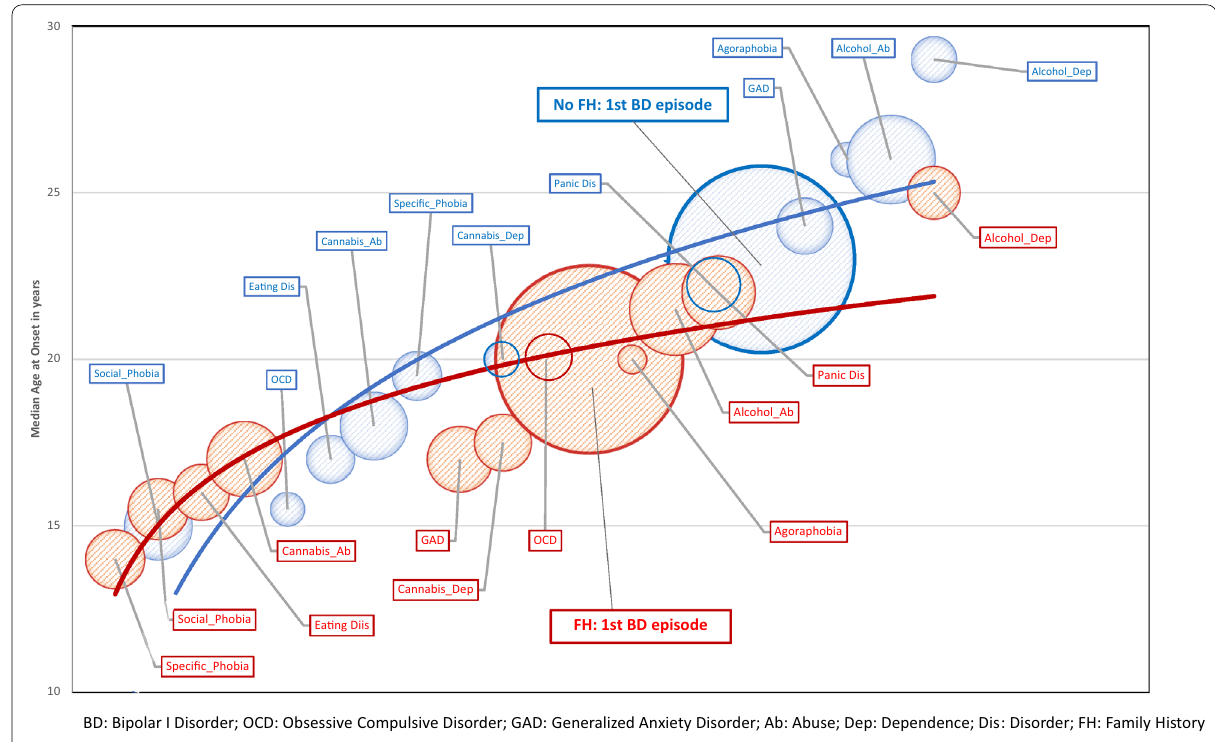
Fig. 1 Trajectories of evolution of BD-I in groups with (FH) or without (no FH) a family history of Bipolar I Disorder (BD). In the bubble plot, the size of the bubble represents the proportion of the group who experience a particular disorder, the position of the bubble vertically gives the median AAO, whilst the position on the horizontal axis approximates to the timing of onset of a disorder in the interval between the onset of the first full threshold mental disorder and the onset of the last comorbidity. For example: in the FH subgroup, the median AAO of the first mental disorder (specific phobia) is about 13–14 years, whilst the median AAO of BD-I is about 20 years. The curve fits less well to the trajectory of comorbidities for the period post-onset of BD-I in the FH group. In the No FH group, the median AAO of the first mental disorder (social phobia) is about 14–15, whilst the median AAO of BD-I is about 22 years. In the No FH group, the curve fits less well to the trajectory path of those antecedent comorbidities with the earliest AAO. The bubbles for BD-I represent 100% in both subgroups. The location of that bubble for FH is lower on the vertical axis, indicating the disorder has an earlier AAO than in the ‘No FH’ group. Also, as can be observed, there appears to be a more obvious clustering of (relatively) early AAO antecedent comorbid disorders within a briefer time interval in the FH group, compared with the No FH group. There are a smaller number of between-group differences in the sequence and onset of different mental